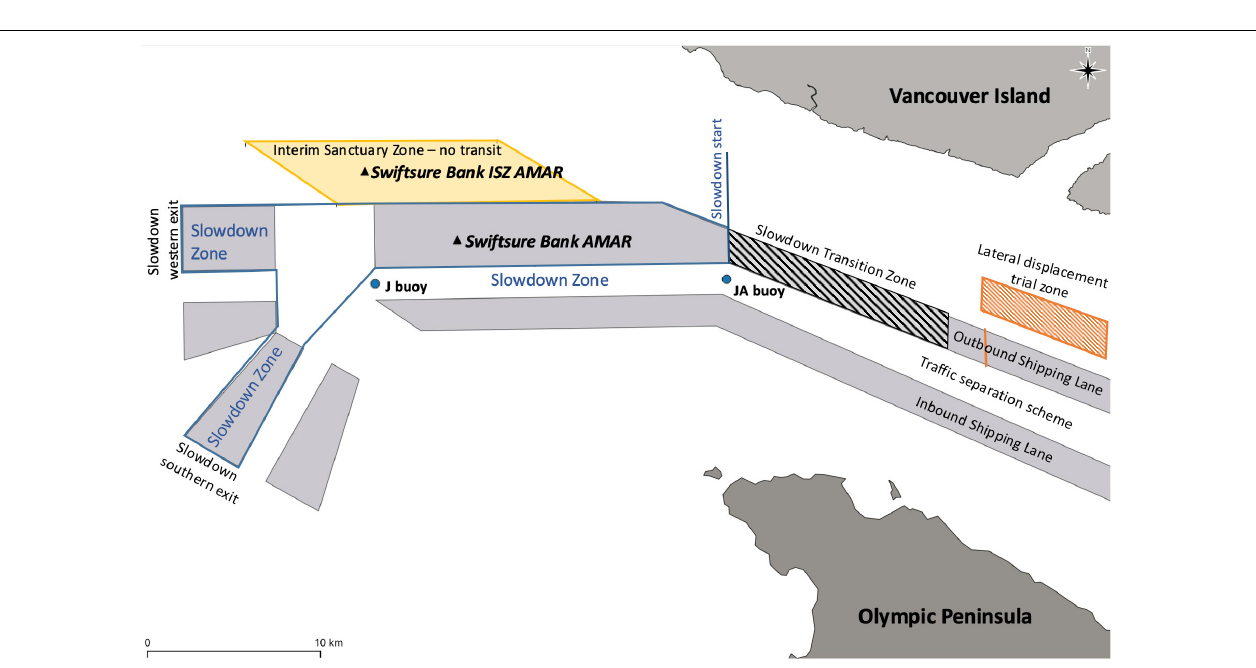
FIGURE 2 | The voluntary slowdown area in Haro Strait and Boundary Pass, and transition zones. The mooring locations used to assess the slowdown are shown with black triangles. Interim Sanctuary Zones (ISZs) are indicated in yellow.